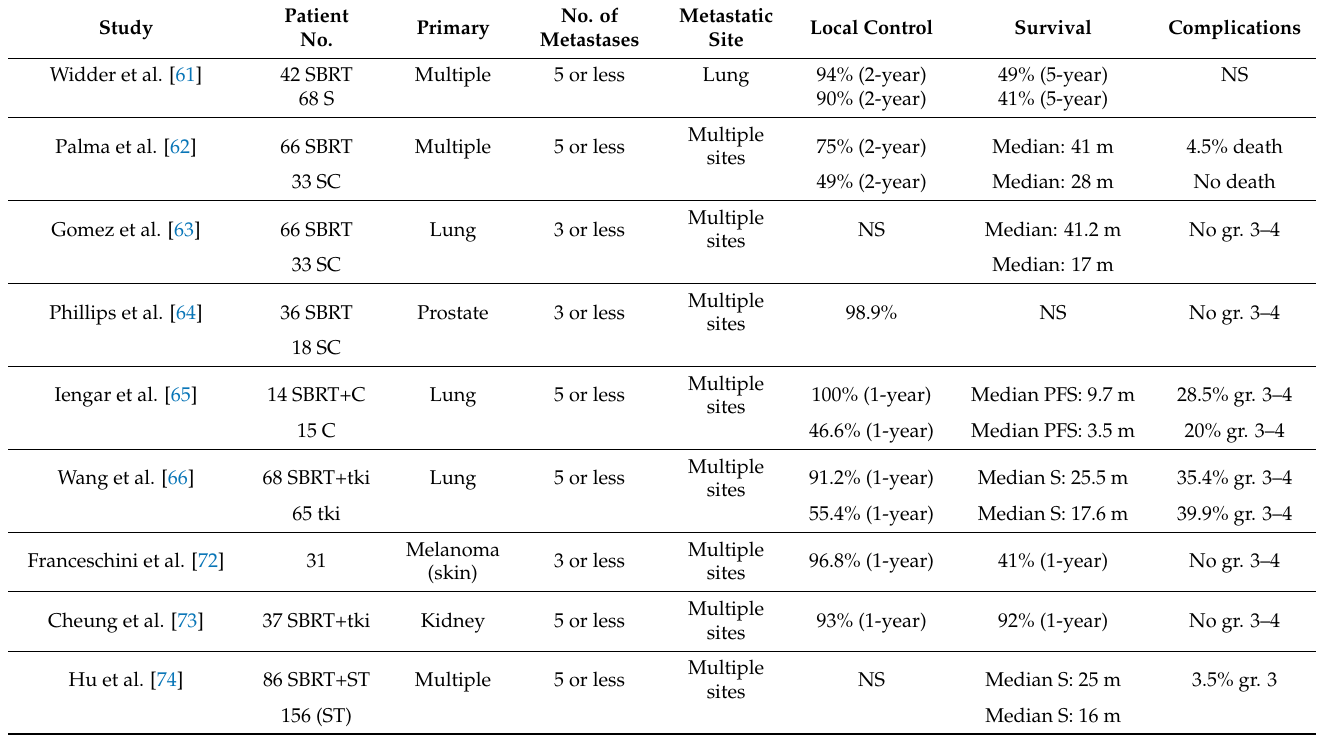
Table 1. Studies summarizing the efficacy of stereotactic body radiotherapy for oligometastases of various tumor types. SBRT, stereotactic body radiotherapy; S, surgery; SC, supportive care; C, chemotherapy; PFS, progression-free survival; tki, tyrosine kinase inhibitor; ST, systemic therapy; NS, not